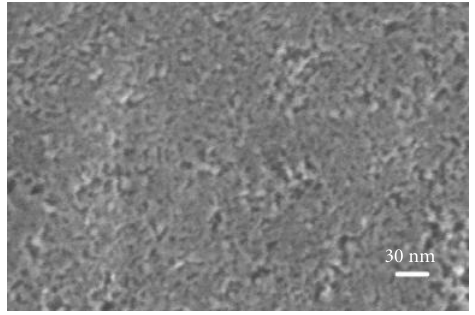
Figure 1: SEM image of 5% TiO 2 / ZrO 2